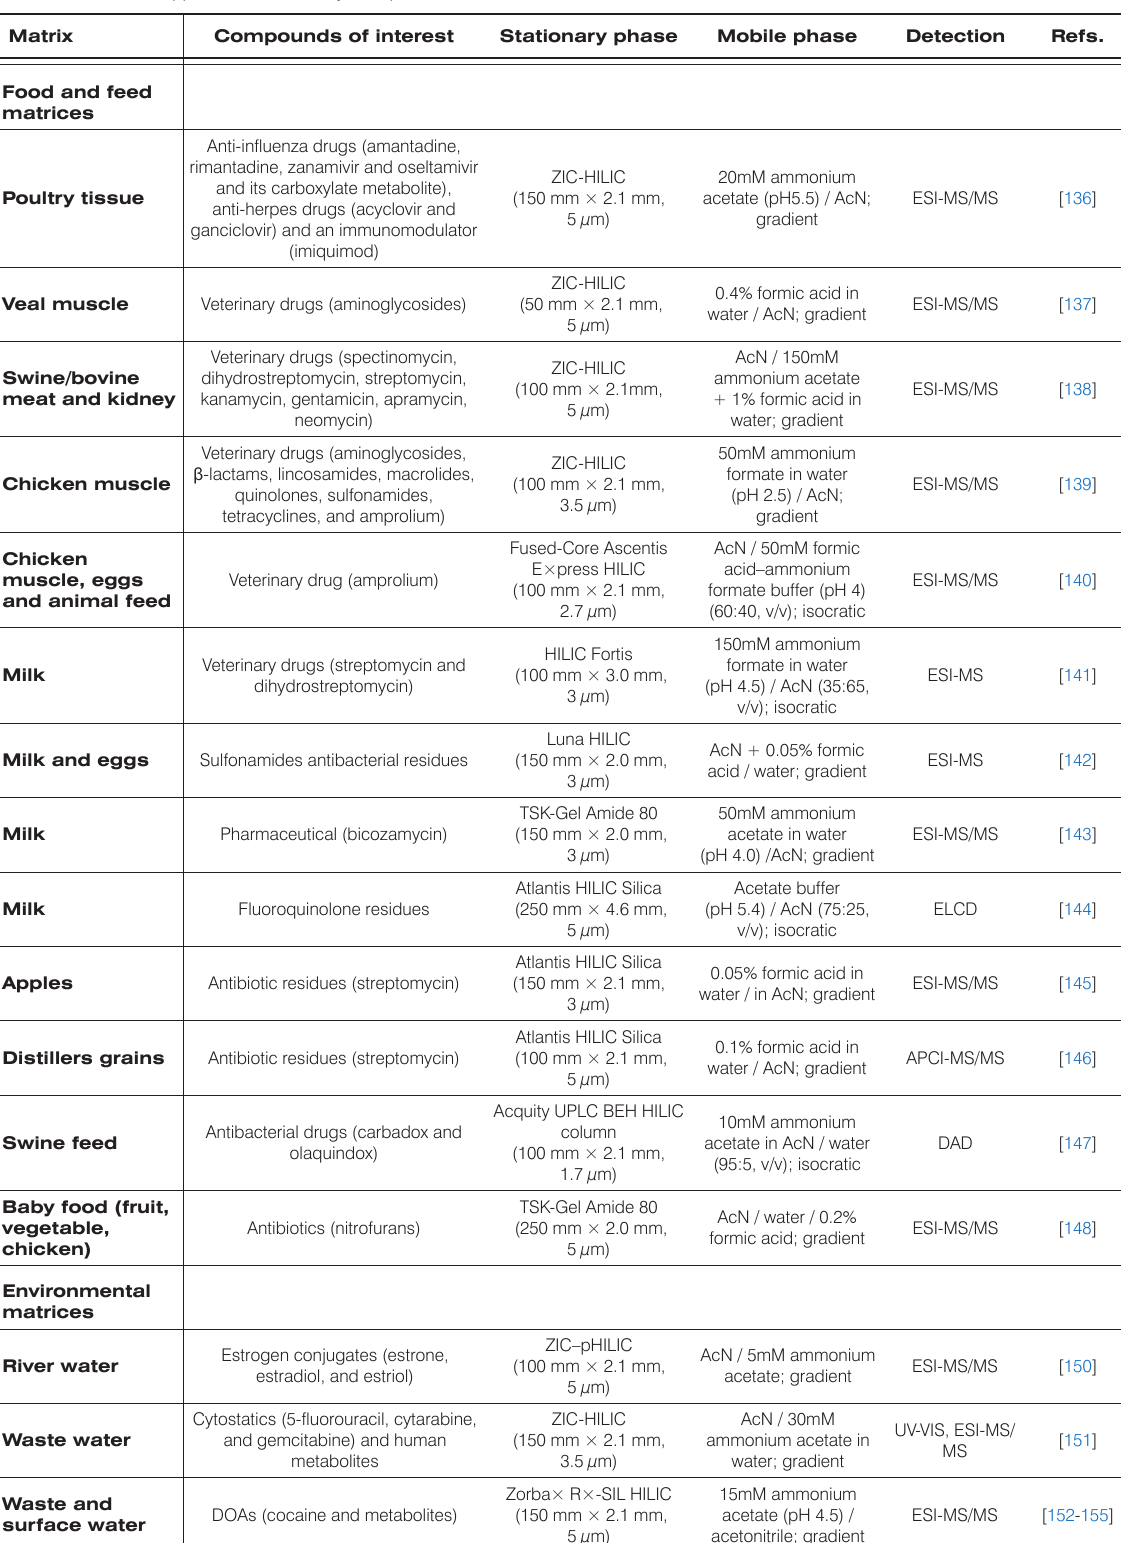
Table 3. - HILIC applications in the analysis of pharmaceuticals in food, feed and environmental